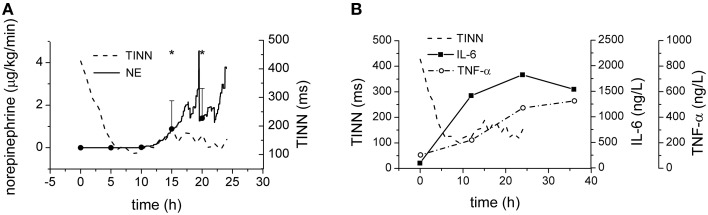
Norepinephrine and cytokines during sepsis progression. (A) Therapeutic doses of norepinephrine during sepsis progression. Full line, average doses of norepinephrine. Dashed line, time course of TINN parameter of HRV. (B) Plasma levels of IL-6 (full line) and of TNF-α (dash-and-dotted line) during sepsis progression. Dashed line, time course of TINN parameter of HRV. *Significantly different from baseline (p < 0.05).